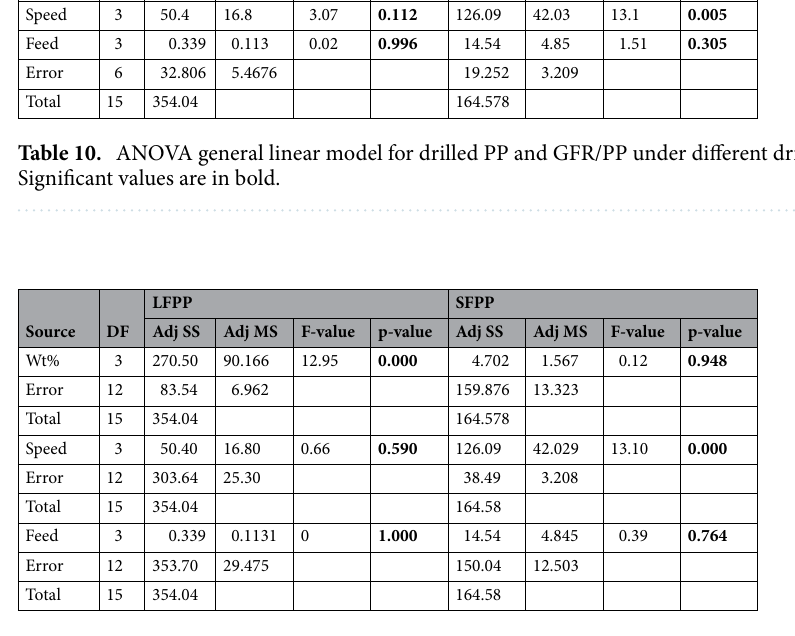
Table 11. One-way ANOVA for drilled PP and GFR/PP under different drilling conditions. Significant values are in bold.